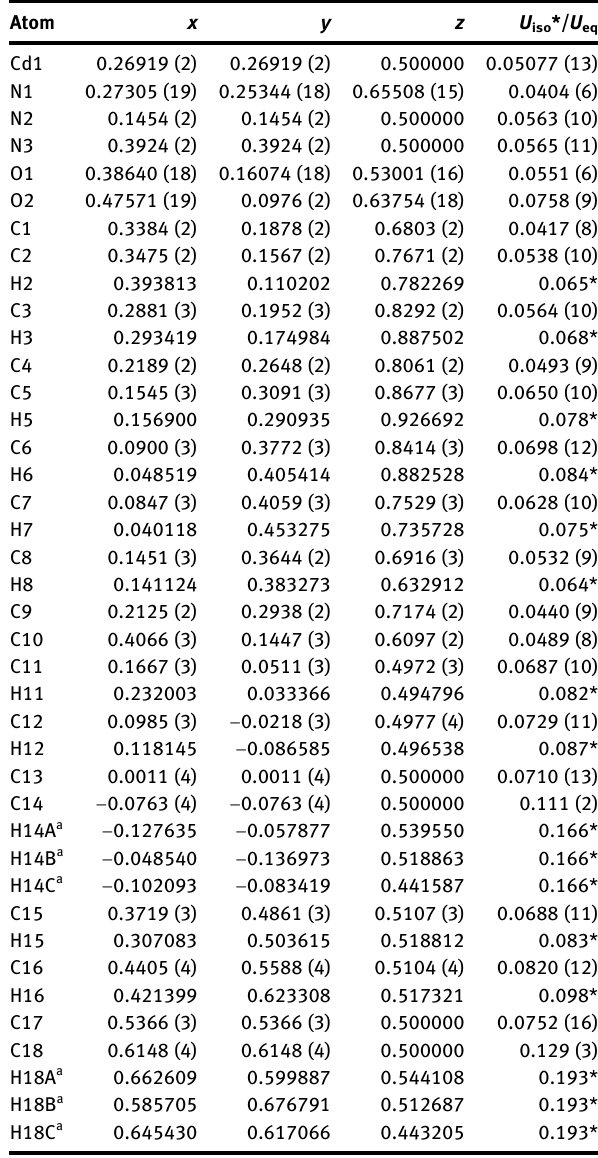
isotropic displacement parameters (Å 